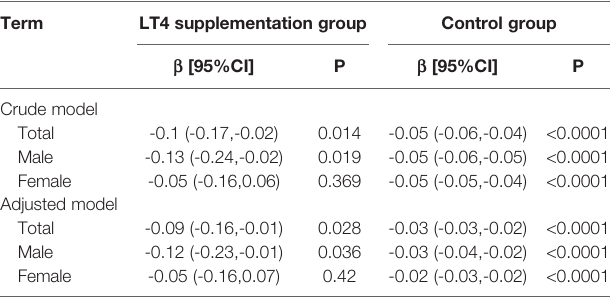
FT4, free thyroxine; LT4, levothyrocine; CI, con fi dence interval. Crude model: without adjustment for potential confounders. Adjusted model: analyses were adjusted for gestation age at birth, maternal age, body mass index (BMI), pregnancy-induced hypertension (PIH), gestational diabetes mellitus (GDM), and fetal